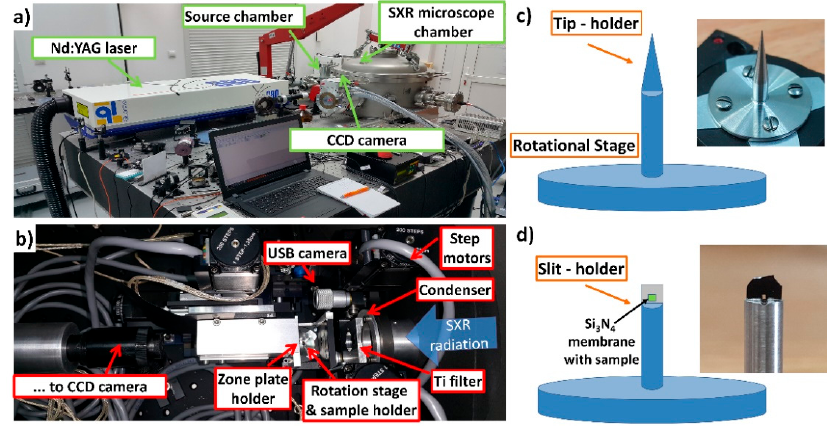
Figure 11. ( a ) SXR tomography setup and ( b ) internal components of the microscope. In ( c ) and ( d ) a scheme and a picture of the tip- and slit-holder are depicted, respectively. Figure modified, based on